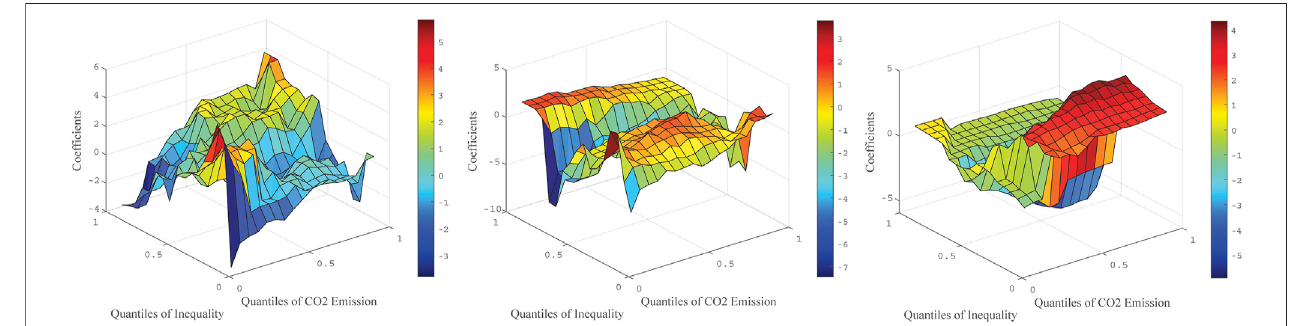
FIGURE 4 | The impact of income inequality on carbon emissions in the short, medium and long term (France).